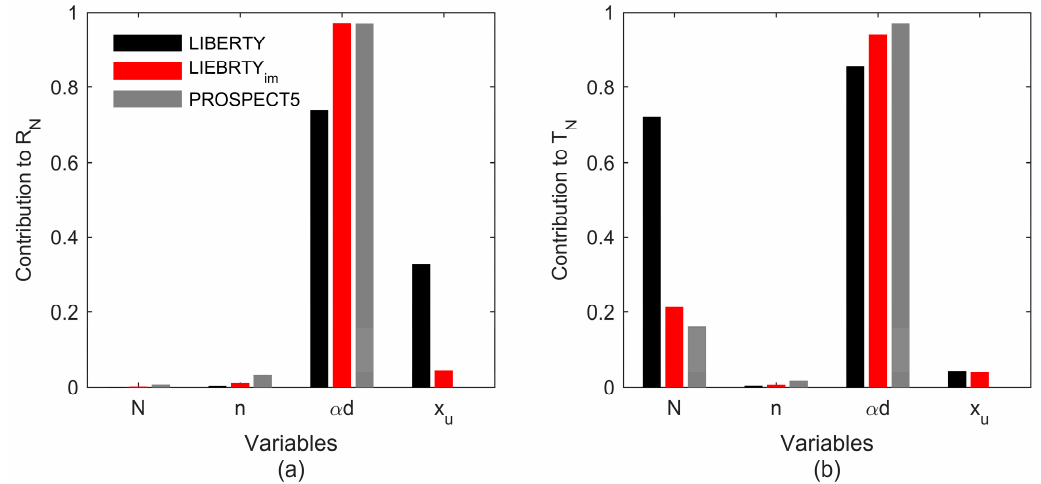
Figure 14. Results of global sensitivity coefficients of ( a ) the global reflectance R N and ( b ) transmittance T N to input variables using Sobel method. N is the structural parameter, n is the relative refractive index, α d is the diametrical absorbance which is assumed to be equivalent to elementary layer absorbance in PROSPECT, x u is the particle backscattering ratio, inter denotes the interactions. Input parameters for models are listed in Table 4. Their ranges were taken from Table 1. The legend is given in the left barplot.